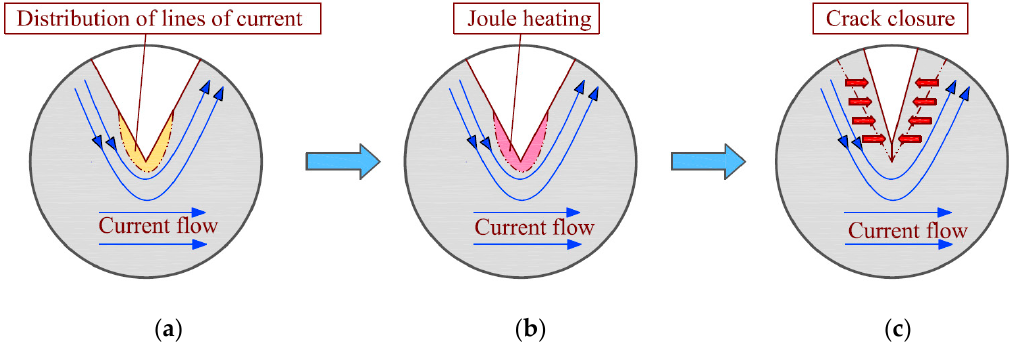
Figure 12. Representation of the EPT application: ( a ) Concentration of electric current field around a crack tip; ( b ) local Joule heating caused by electric current field around a crack tip; ( c ) crack closure resulting from thermal expansion and thermal compressive stress.